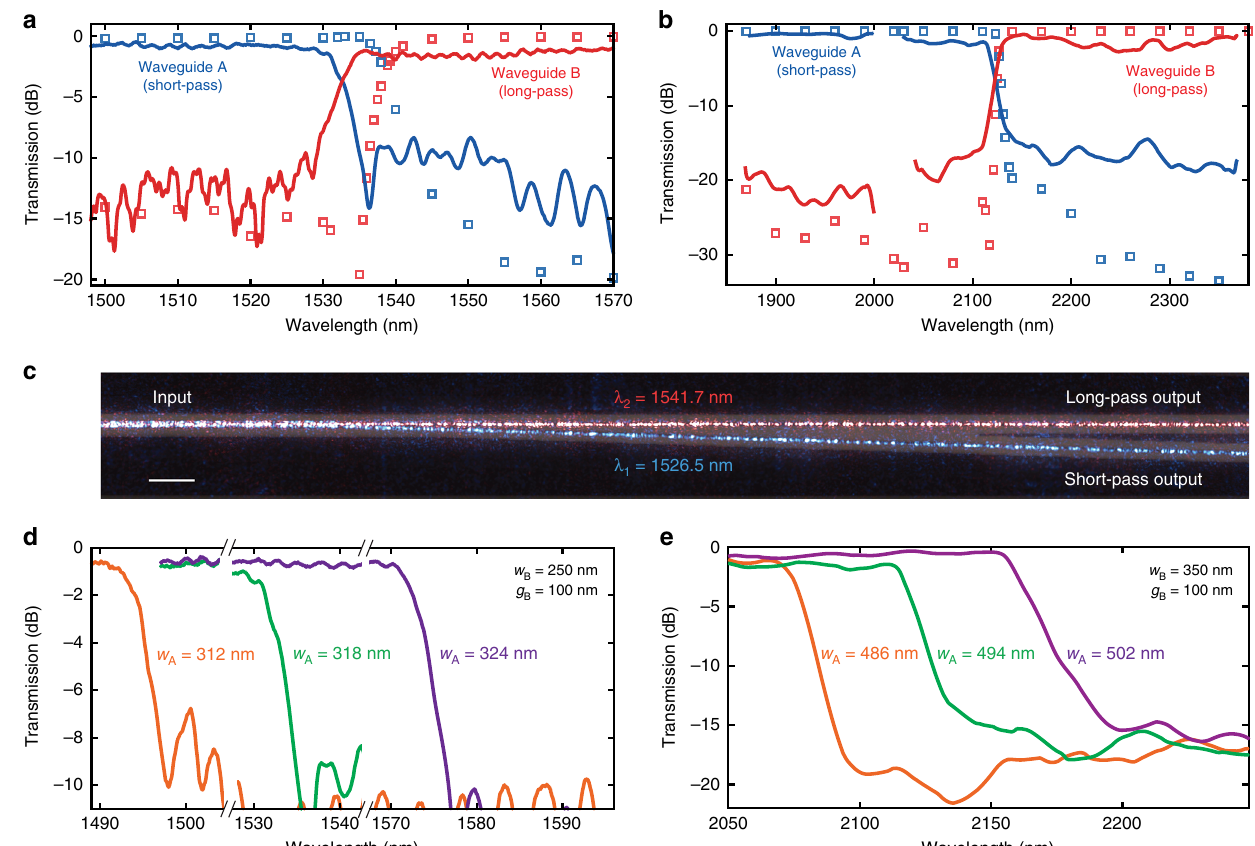
Fig. 5 Measured and simulated spectral transmissions of dichroic fi lters. a Measurement (solid) and simulation results (squares) for the fi lter designed for C- band operation. The roll-off of power around the cutoff reaches 2.82dBnm − 1 . Measured and simulated cutoff wavelengths are 1533.3 and 1539.6nm, respectively. b A similar fi lter designed for operation around 2100nm plotted with measured (solid) and simulated (squares) transmissions. Power roll-off for this longer wavelength fi lter is 0.64dBnm − 1 around the cutoff. Measured and simulated cutoff wavelengths are 2119.9 and 2128.6nm, respectively. c Overlaid, colorized infrared images of light at wavelengths below and above the cutoff propagating through the dichroic fi lter and being separated to the respective output ports. Scale bar, 30 μ m. d Shift of cutoff wavelengths for the C-band fi lter due to increasing w A from 312 to 324nm. e Similar shifts for the 2100nm fi lter with w A increasing from 486 to 502nm. All eigenmode expansion simulated and measured cutoff wavelengths are summarized in Table